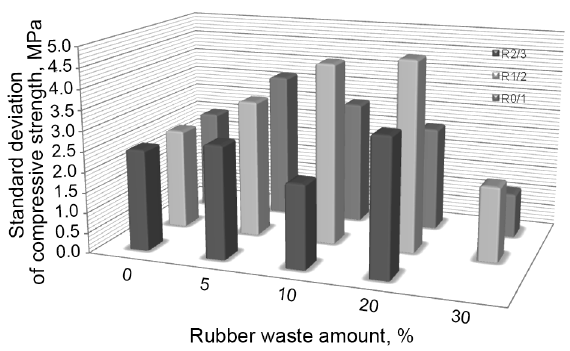
Fig. 3. Standard deviation of the compressive strength of con- crete